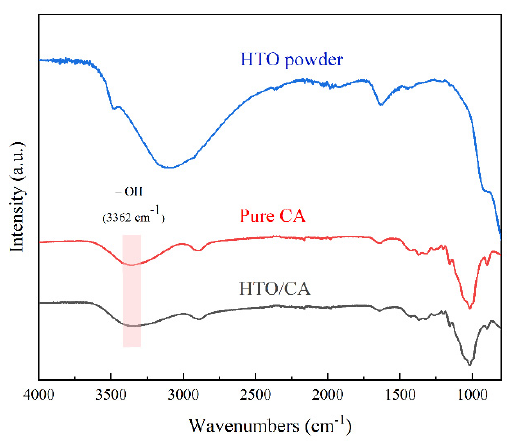
Figure 4. FTIR spectra of the pure CA, HTO powder, and HTO/CA.